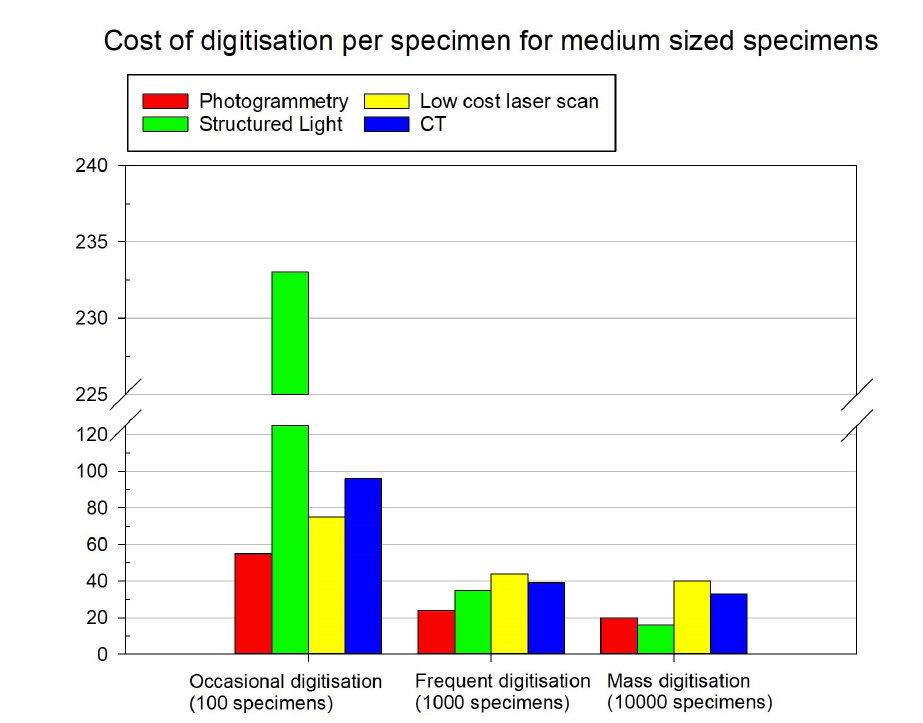
Fig. 6.12. Cost/efficiency ratio of digitisation for middle sized specimens. (CT is based on a rental service, while the others include the purchase of the equipment).